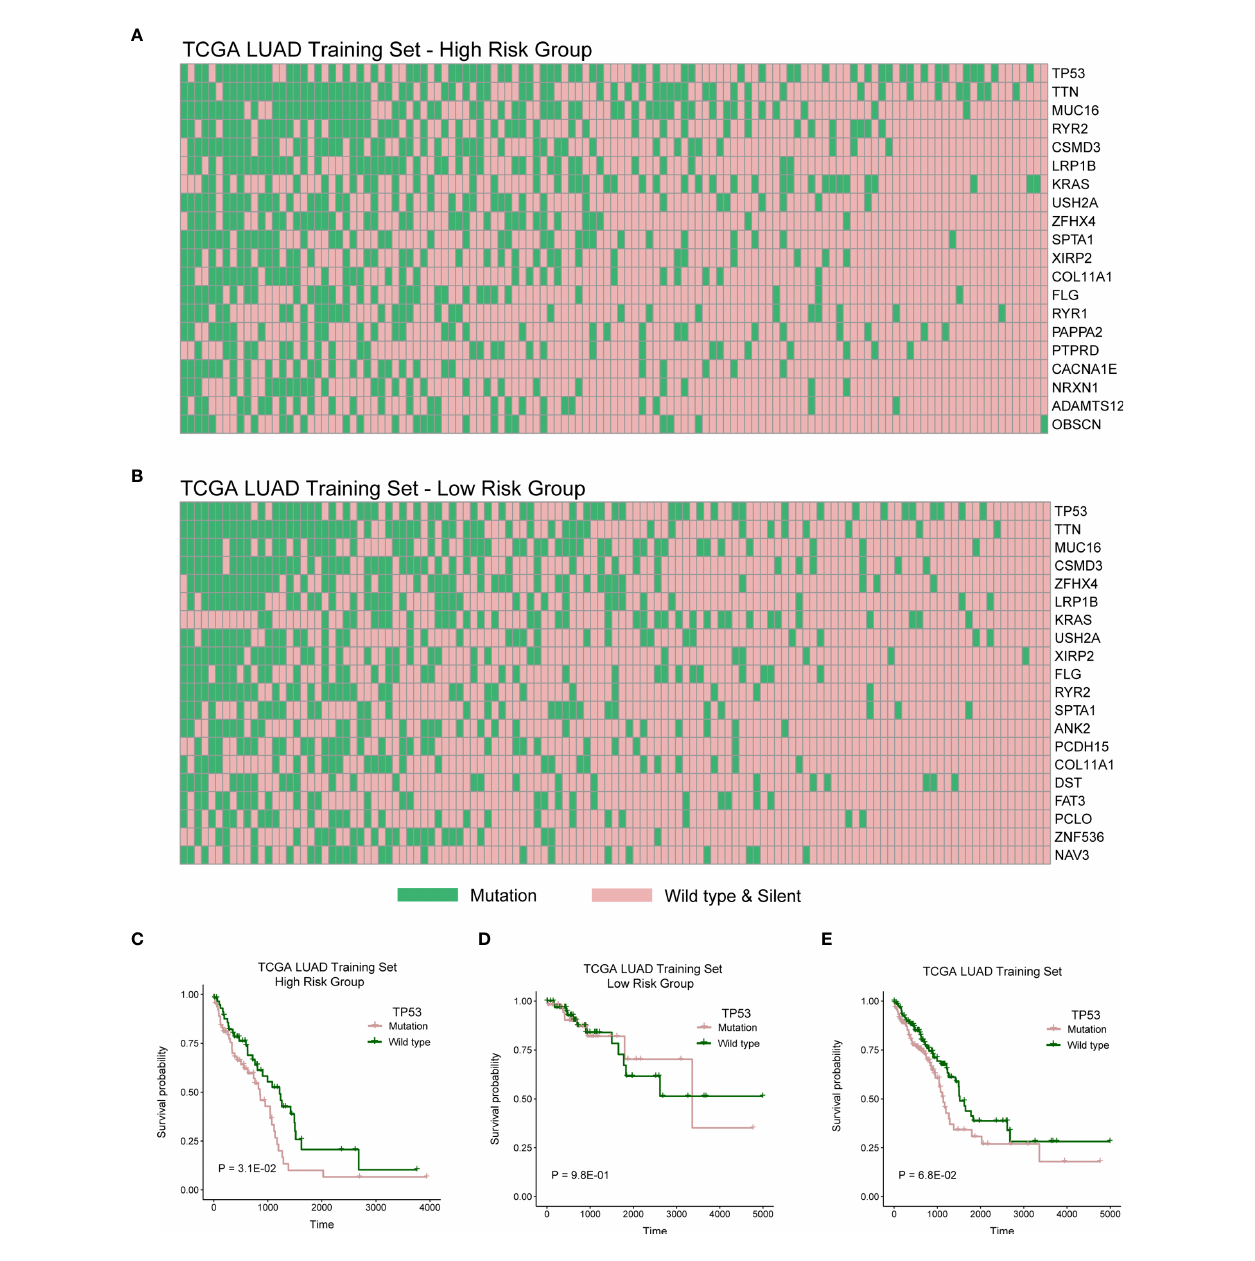
FIGURE 6 | High- and low-risk groups with different distribution of mutation. (A) The distribution of top 20 genes with high frequency in high-risk group of TCGA LUAD training cohort. (B) The distribution of top 20 genes with high frequency in low-risk group of TCGA LUAD training cohort. (C – E) Log-rank test was used to assess the difference in OS between TP53 mutation and wild type samples in TCGA LUAD training cohort with high risk, TCGA LUAD training cohort with low risk, or TCGA LUAD training